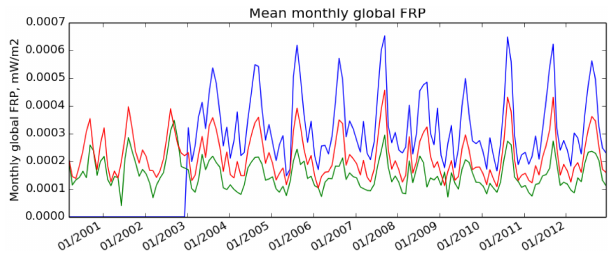
Figure 12. Monthly global FRP from Terra (green), Aqua (blue) and GFAS (red). Before 01/01/2003, GFAS uses Terra observations corrected with a combination of linear and non-linear regression; after 01/01/2003, GFAS uses observations from Aqua and